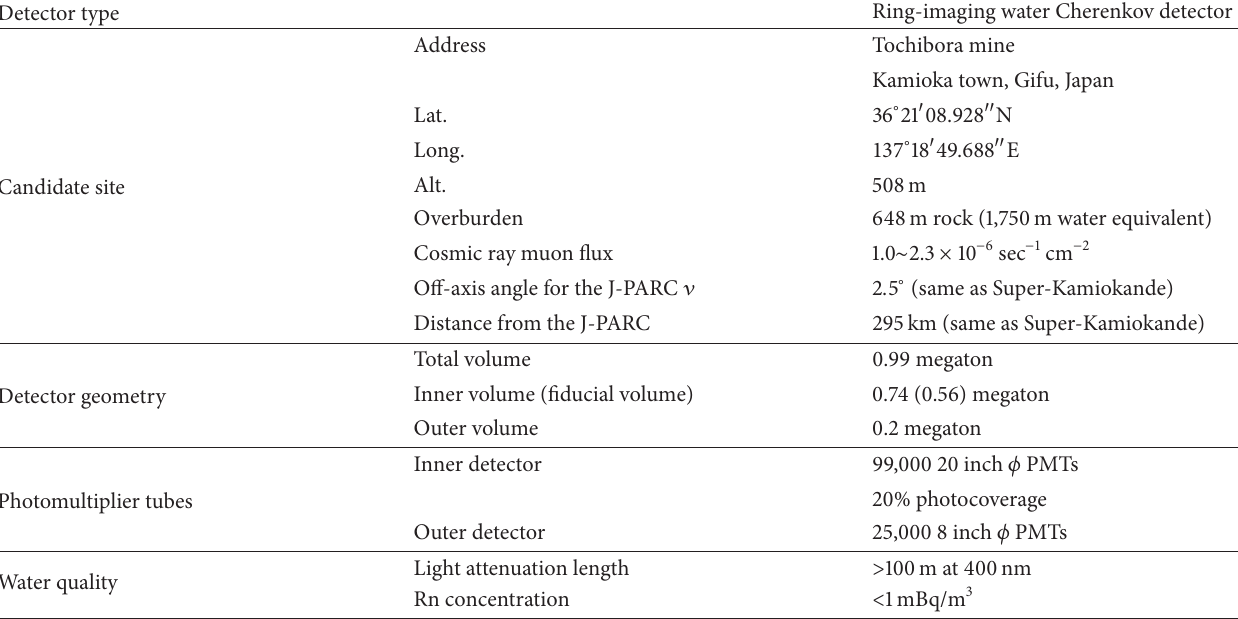
Table 6: Detector parameters of the baseline design.